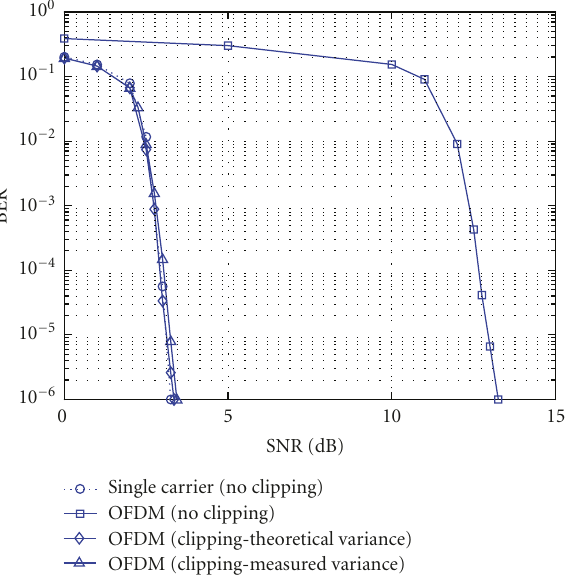
Figure 4: BER versus SNR for single carrier and OFDM systems with LDPC (3312, 1397) coding over AWCN channel ( A = 0 . 1, GIR = 0 .